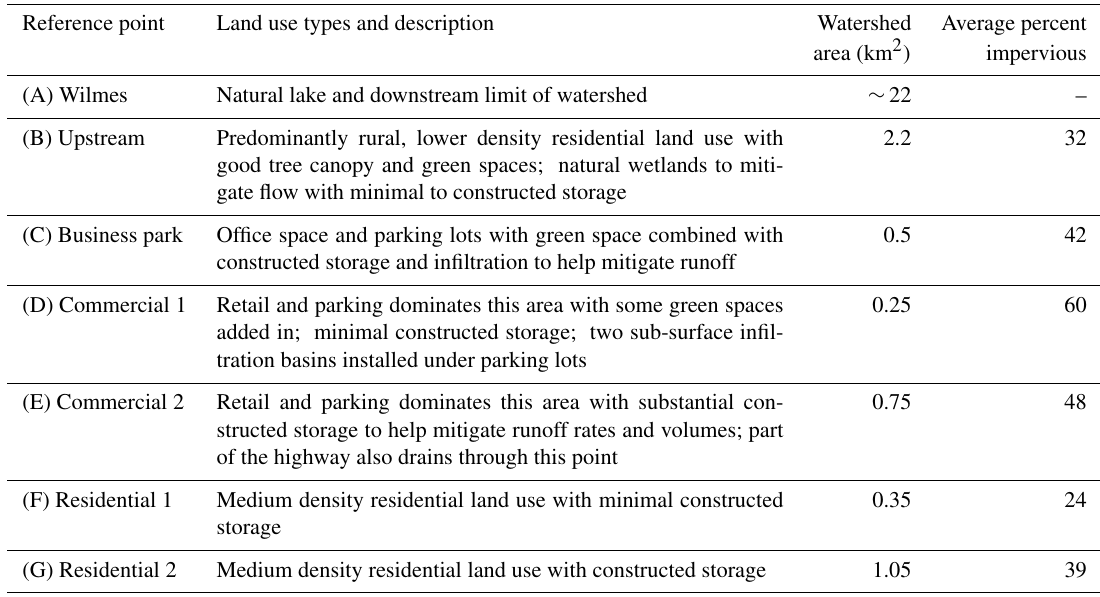
Table 1. Description of reference locations presented in Fig. 1 and used to present results. Each location represents a variation of land use within the watershed.